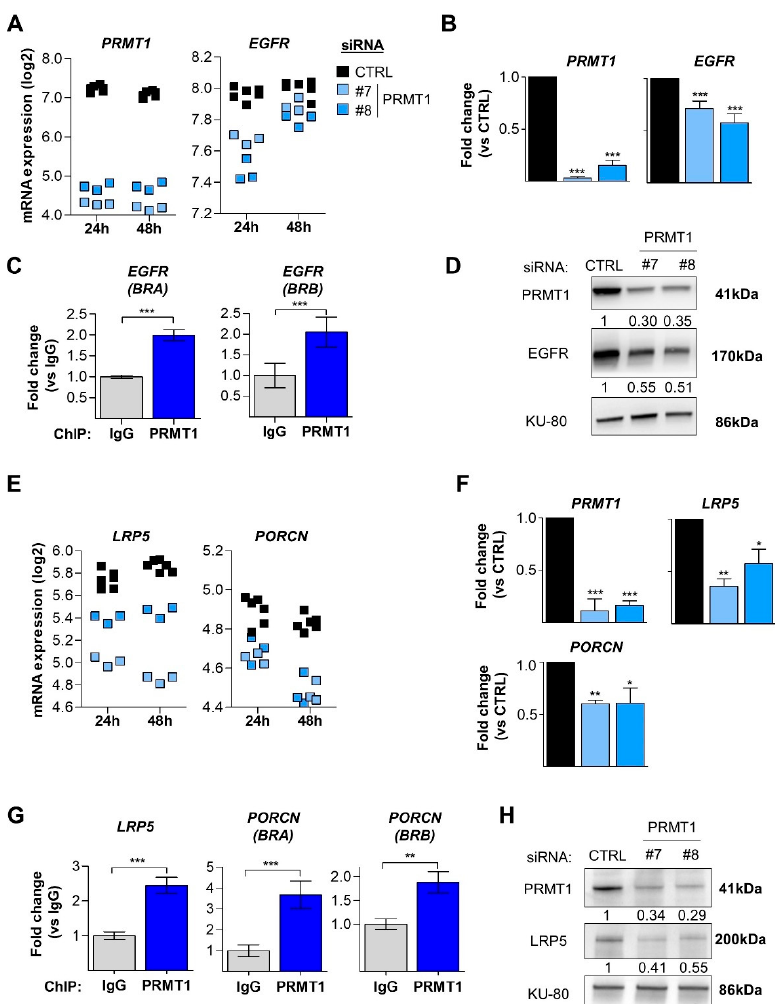
Figure 4. PRMT1 is enriched on the promoter of EGFR , LRP5 and PORCN and activates their transcription. ( A , B ) PRMT1 depletion in MDA-MB-468 cells reduces EGFR mRNA expression as shown by Affymetrix microarray ( A ) and verified by qPCR ( B ). ( C ) PRMT1 is recruited to two promoter regions (Binding Region A, BRA; BRB) of EGFR . ( D ) PRMT1 depletion reduces EGFR protein level as shown by Western blotting. ( E , F ) PRMT1 depletion reduces LRP5 and PORCN mRNA expression as shown by Affymetrix microarray ( E ) and validated by qPCR ( F ). ( G ) PRMT1 is recruited to the promoter of LRP5 and two promoter regions (BRA, BRB) of PORCN . ( H ) PRMT1 depletion reduces LRP5 protein level as shown by Western blotting. MDA-MB-468 cells were transfected with control (black) or two PRMT1 (#7, #8, blue) siRNAs for 24 h ( A , B , E ) and 48 h ( A , D – F , H ). mRNA expression was logarithmically transformed (log 2) and each replicate is represented as a single point on the scatter plot ( A , E ). ChIP experiments were performed using anti-PRMT1 (blue bars) or anti-IgG (grey bars) antibodies using chromatin isolated from MDA-MB-468 cells ( C , G ). qPCR was performed using primers targeting the promoter regions of EGFR ( C ), LRP5 ( G ) and PORCN ( G ). PRMT1 depletion was verified in the Affymetrix microarray ( A ), by qPCR ( B , F ) and by Western blotting ( D , H ). Antibody against KU-80 was used as a loading control for the Western blots and pictures are representative of at least three independent experiments ( D , H ). Intensity ratios of the bands, indicated below each blot, represent a fold change relative to control siRNA, after normalization to the loading control ( D , H ). The quantifications are represented as a fold change relative to the control siRNA ( B , F ) or control IgG ( C , G ) and presented as mean ± SD ( B , F ) or mean ± SEM ( C , G ) from three independent experiments. p -values from Student t -test are represented as * p < 0.05; ** p < 0.01; *** p <